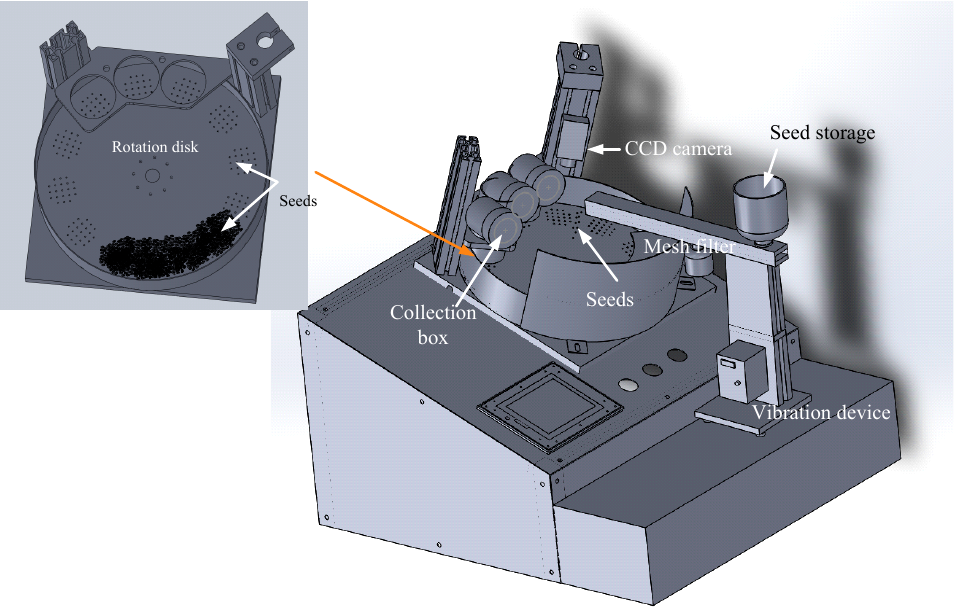
Figure 2. Configuration diagram of auto-sorting device for Chinese cabbage seeds.